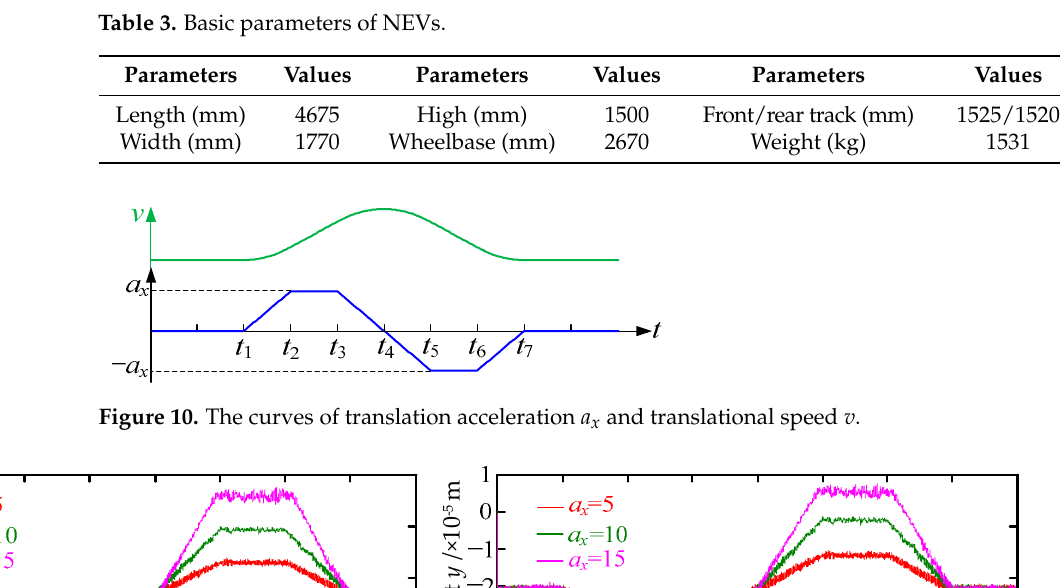
Figure 10. The curves of translation acceleration a x and translational speed v.